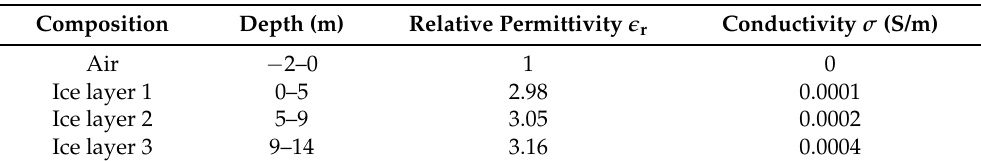
Table 1. The 3D ice structure model parameters.